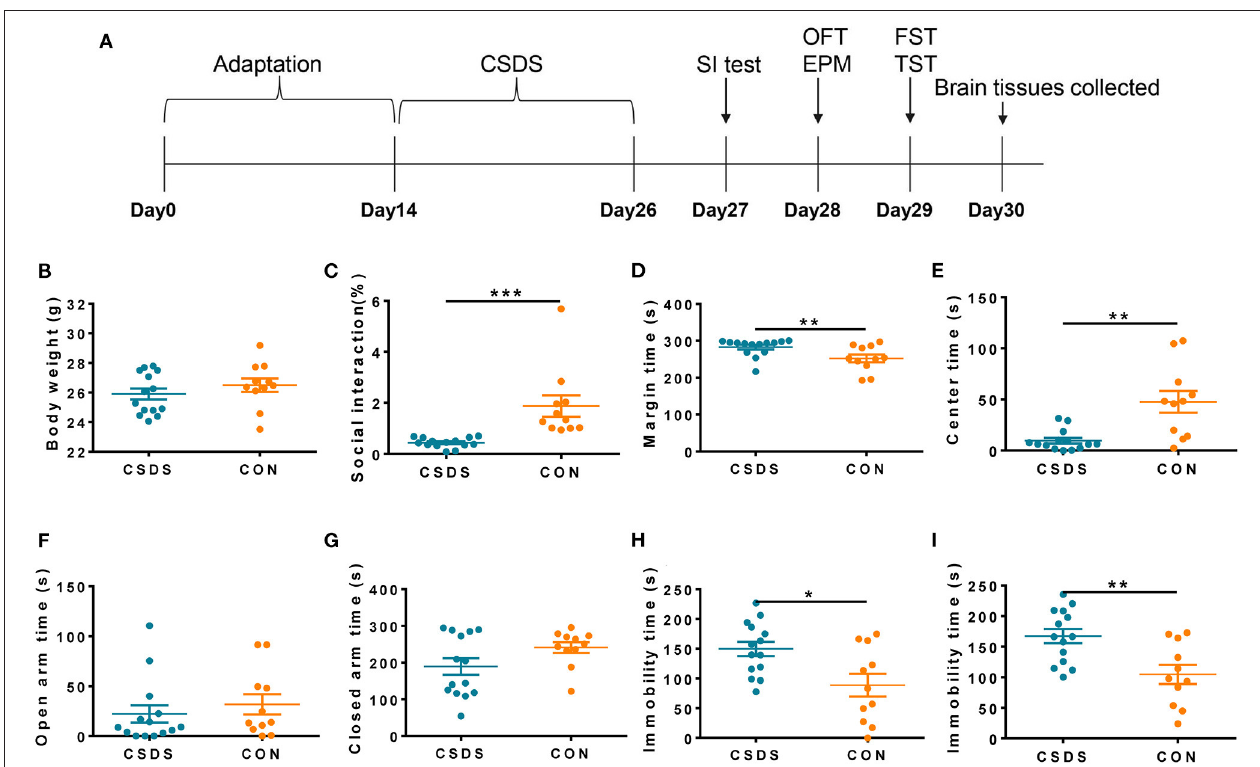
FIGURE 5 | Generation of the chronic social defeat stress (CSDS) depression mouse model. (A) Schedule of the experimental process. (B) No significant difference was found in body weight between CSDS and control mice. (C) The social interaction (SI) ratio was significantly reduced in the SI test in CSDS mice compared with control mice. (D,E) CSDS mice spent significantly more time in the perimeter area and significantly less time in the central area in the open field test compared with control mice. (F,G) No significant differences were found in time spent in open arms or closed arms in the elevated plus-maze test between CSDS and control mice. (H,I) Immobility time was significantly increased in CSDS mice in the forced swimming test and the tail suspension test compared with control mice. Data represent the mean ± SEM. * p < 0.05, ** p < 0.01, and *** p <